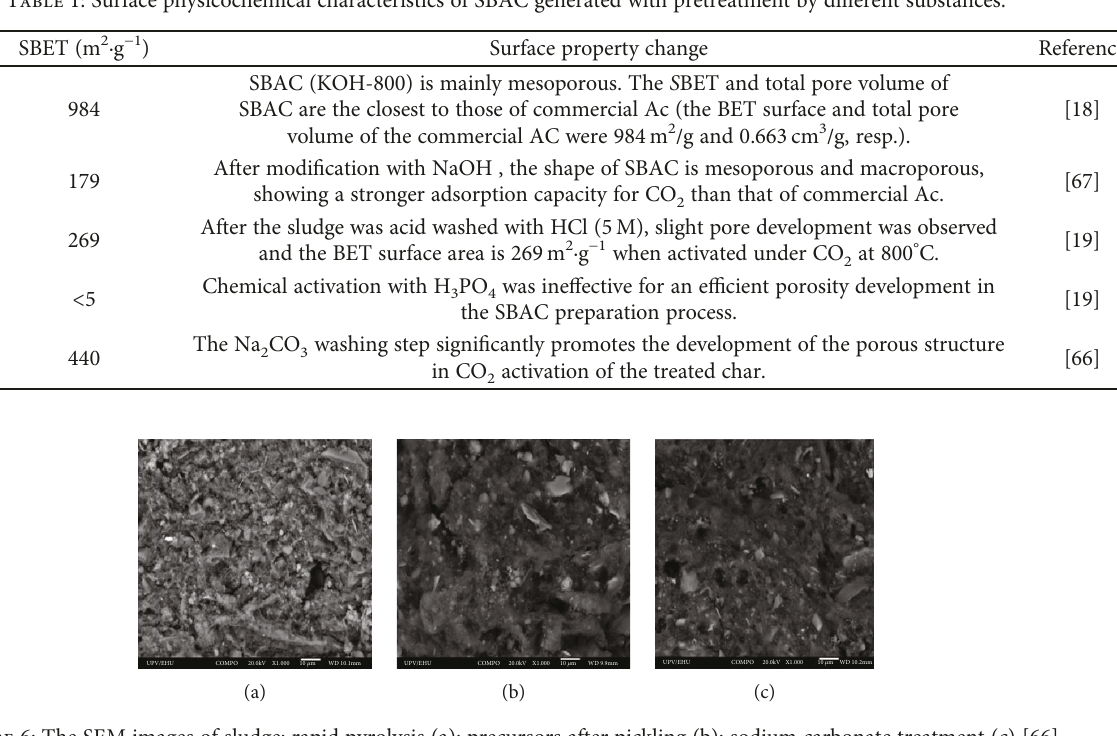
Figure 6: The SEM images of sludge: rapid pyrolysis (a); precursors after pickling (b); sodium carbonate treatment (c)